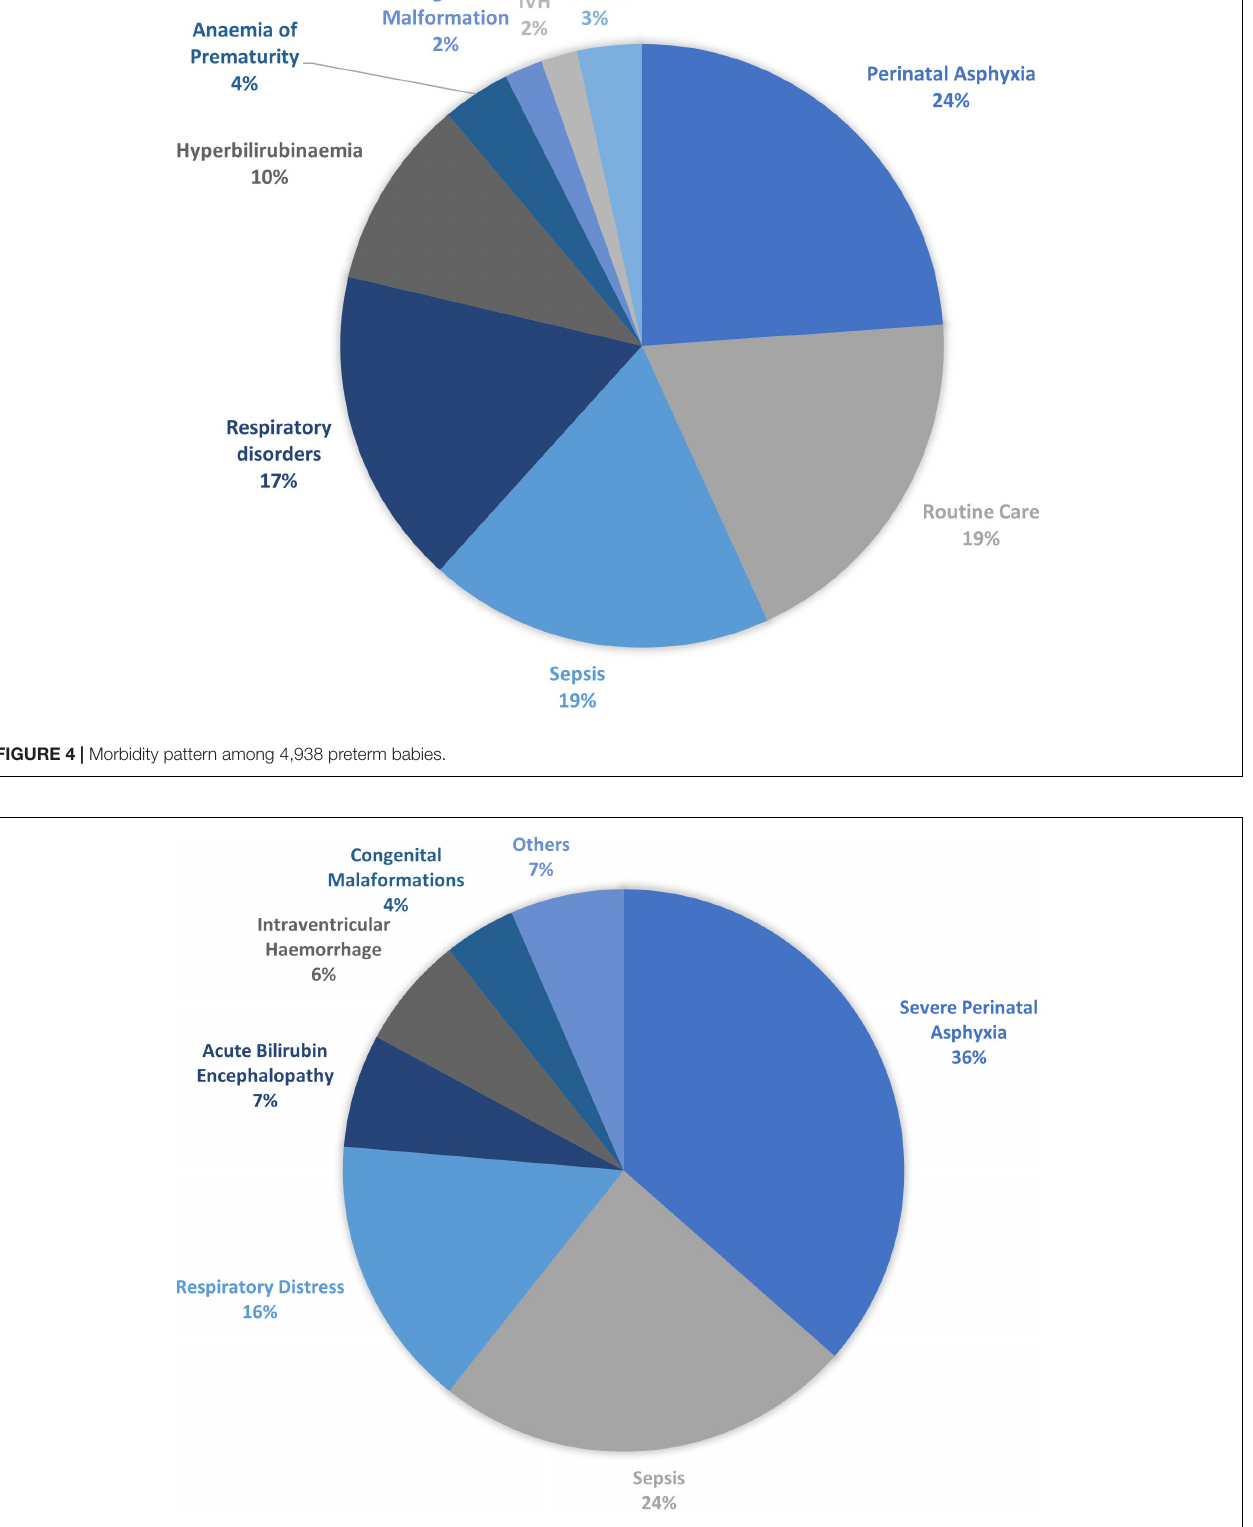
FIGURE 5 | Cause of mortality among preterm